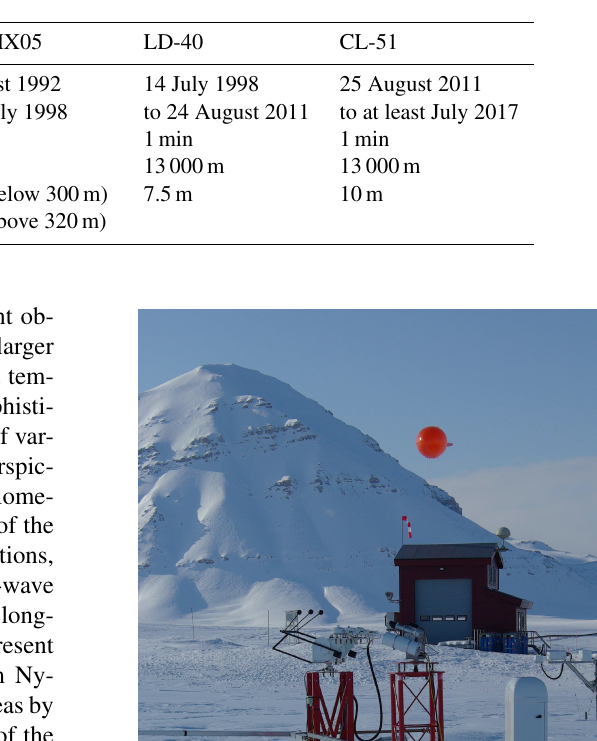
Table 1. The three instrument types that contributed to the cloud base height data set by ceilometer measurements in Ny-Ålesund, and the temporal and spatial resolution of their data.